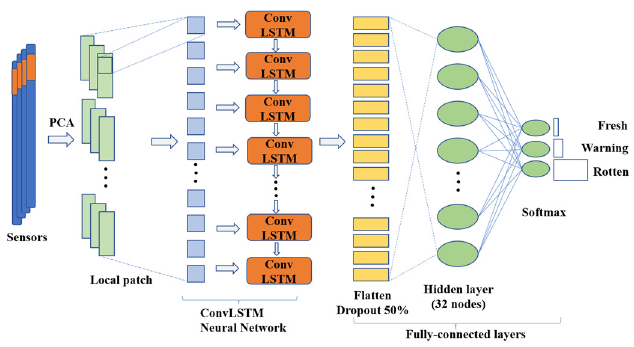
Figure 20. Structure of the ConvLSTM model.